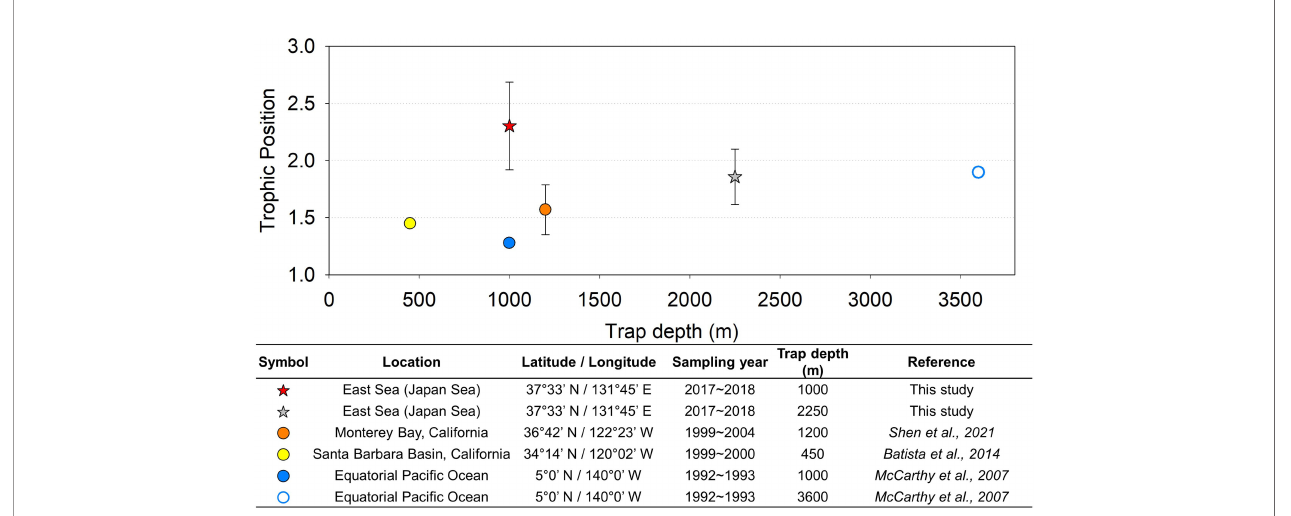
FIGURE 8 | Trophic position of sinking particles in this study and reference literatures. Note that all TP values were calculated with same equation used in this